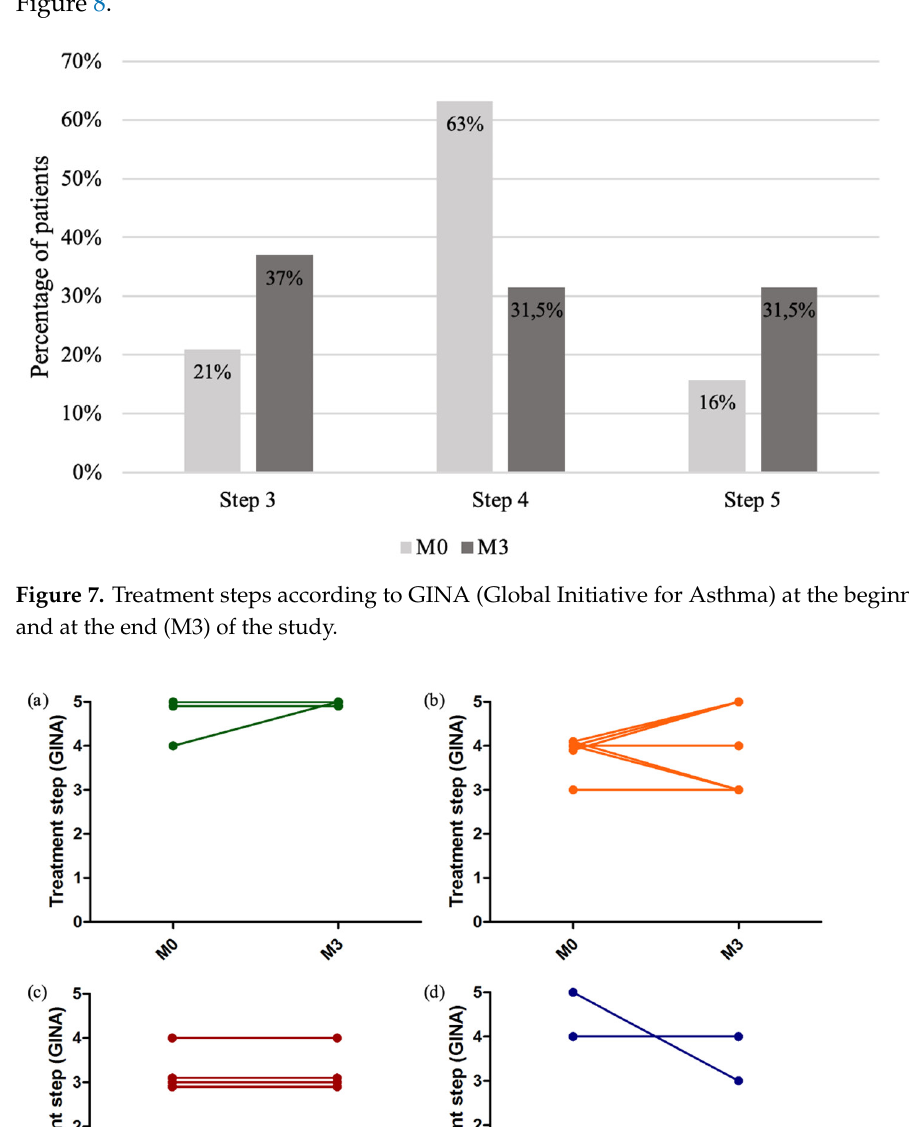
Figure 8. Treatment steps according to GINA (Global Initiative for Asthma) at the beginning (M0) and at the end (M3) of the study according to the perception profile. Each line represents one patient. ( a ) good perceivers; ( b ) anarchic perceivers; ( c ) poor perceivers; ( d ) excessive perceivers.